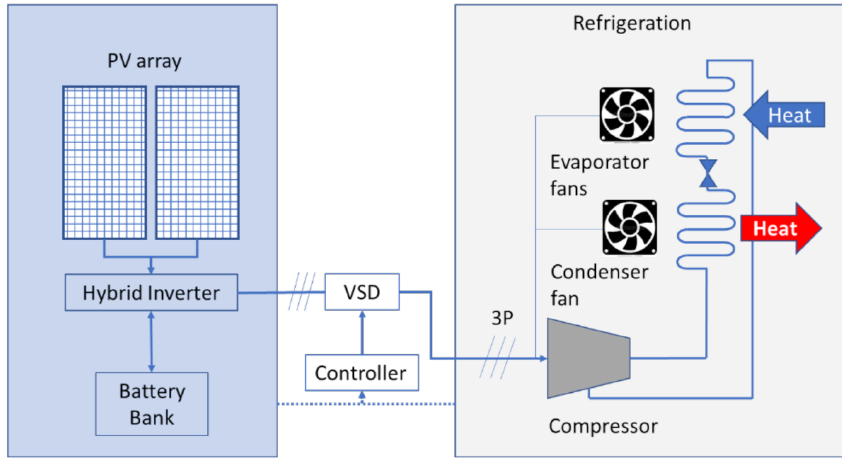
Figure 4. Advanced electrical architecture for a solar-powered cold storage